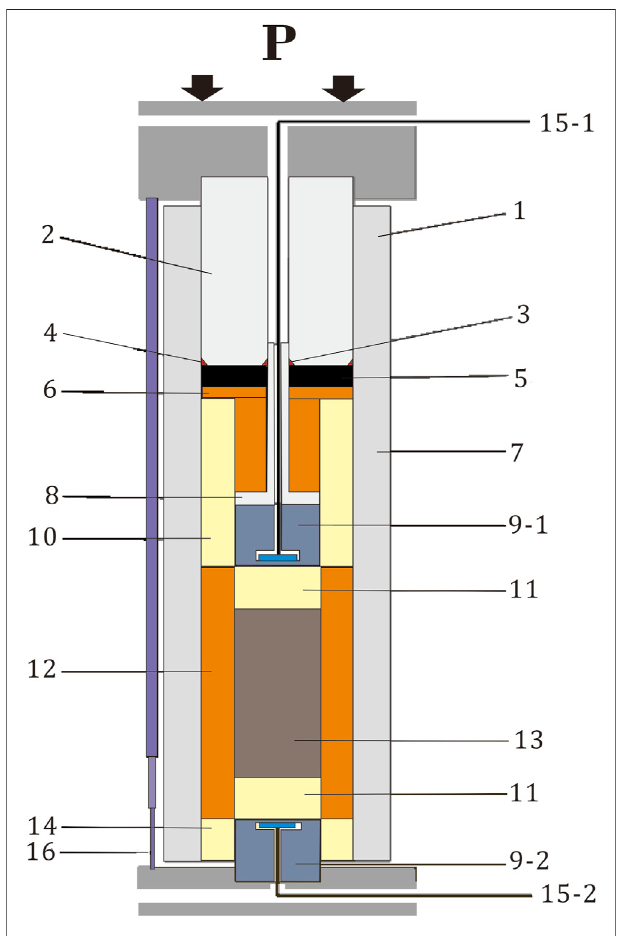
FIGURE 2 | Schematic of the sample assembly and layout of the ultrasonic transducer: (1) tungsten carbide sample chamber; (2) tungsten carbide piston indenter; (3) inner copper triangular seal ring; (4) outer copper triangular seal ring; (5) lead pad; (6) pyrophyllite pad; (7) pyrophyllite column; (8) T-shaped steel pipe; (9-1) and (9-2) upper and lower ultrasonic transducers, respectively; (10) alumina jacket; (11-1) and (11-2) upper and lower corundum pillars; (12) pyrophyllite coat; (13) samples; (14) alumina jacket; (15-1) and (15-2) ultrasonic transducer leads; and (16) displacement